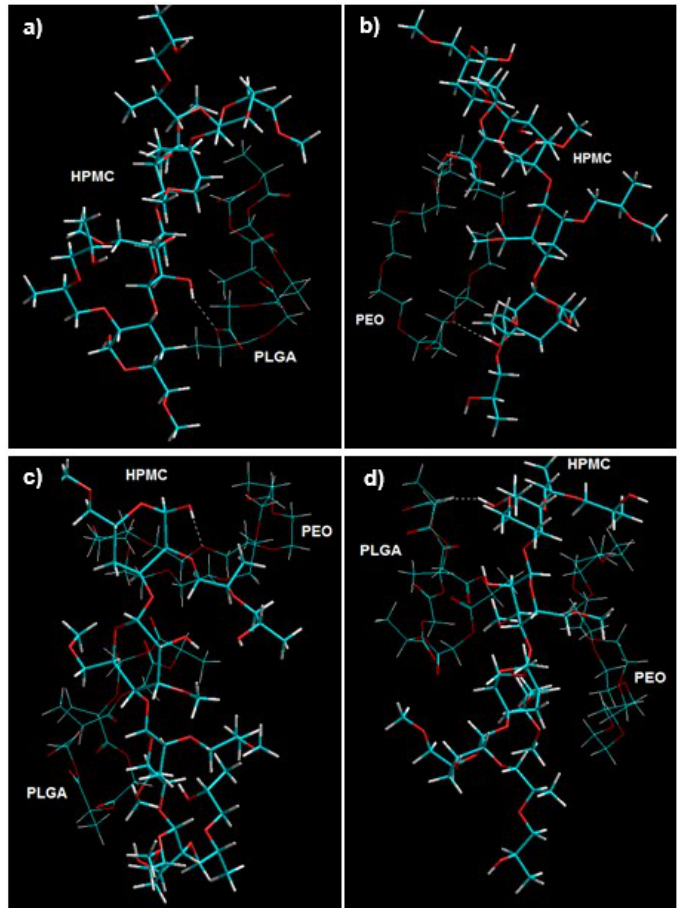
Figure 6. Visualization of geometrical preference of ( a ) PLGA in complexation with HPMC; ( b ) PEO in complexation with HPMC; ( c ) PLGA–HPMC–PEO tripolymeric comples with PEO H-bonded to HPMC; and ( d ) PLGA–HPMC–PEO tripolymeric complex with PLGA H-bonded to HPMC after molecular mechanics simulations. Color codes: C (cyan), O (red), N (blue), and H (white).